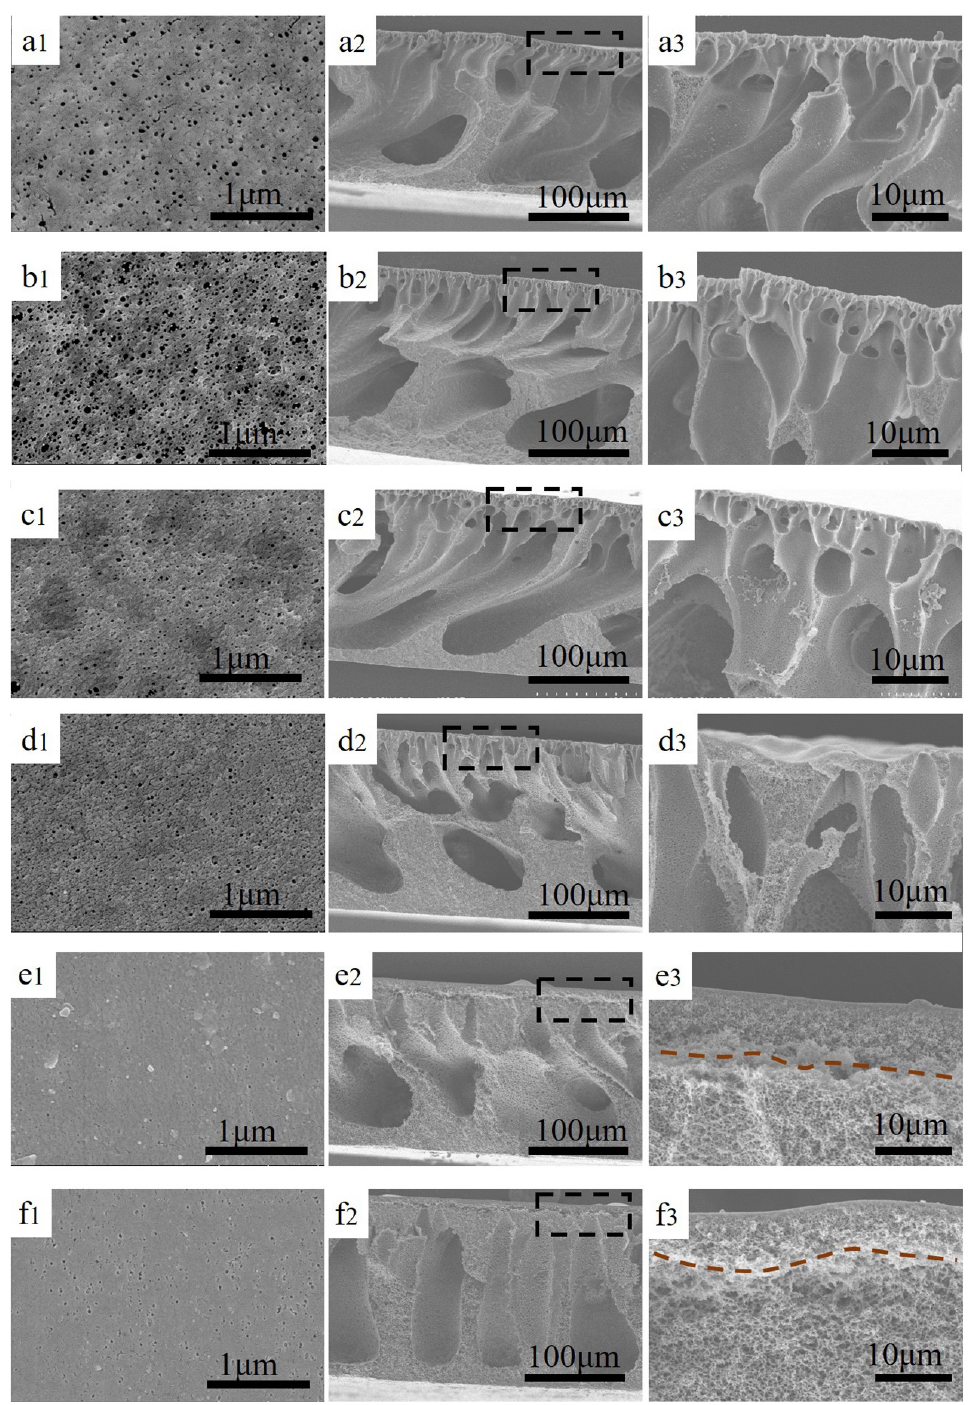
Figure 1. The surface and cross-sectional images of different supports: ( a1 – a3 ) support-0, ( b1 – b3 ) support-1, ( c1 – c3 ) support-2, ( d1 – d3 ) support-3, ( e1 – e3 ) support-4, ( f1 – f3 )